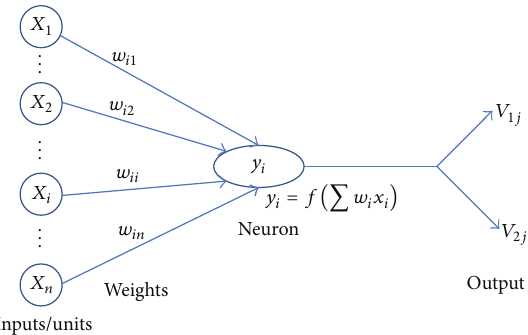
Figure 5: Generic artificial neural network